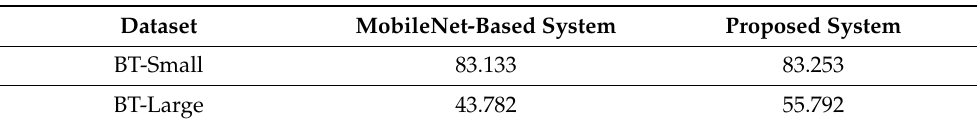
Table 11. Comparison of the classification accuracies between the MobileNet-based classification system and our proposed method (unit: